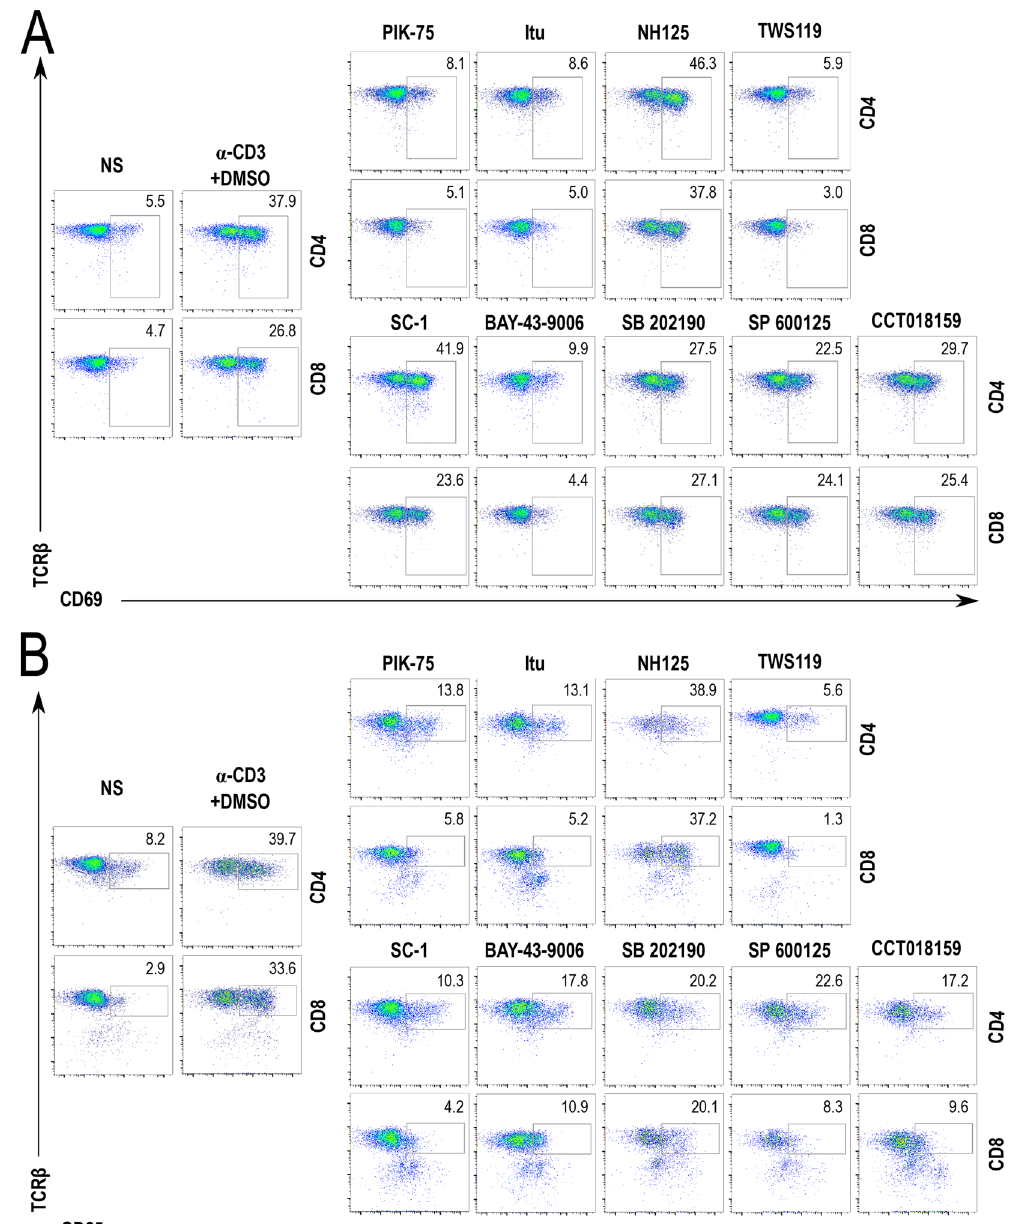
Figure 4. Identification of known and new inhibitors of lymphocyte activation among positive hits from the functional screen. ( A ) Flow cytometry plots showing the effects of selected inhibitors on CD69 upregulation in peripheral lymphocytes following a 3 h stimulation with plate bound anti-CD3 antibody. (B) Effects of same inhibitors on CD25 upregulation following an 18 h stimulation. Representative plots of the controls (NS and α -CD3 + DMSO) shown here were selected from a set of quadruplicates. Individual compounds were tested individually without replicates. NS: Non-stimulated samples (negative control); α -CD3 + DMSO: samples stimulated in the presence of DMSO (positive